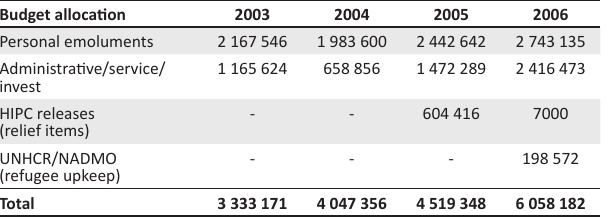
TABLE 4: The National Disaster Management Organisation’s budgetary allocation (Ghana cedis) . Budget